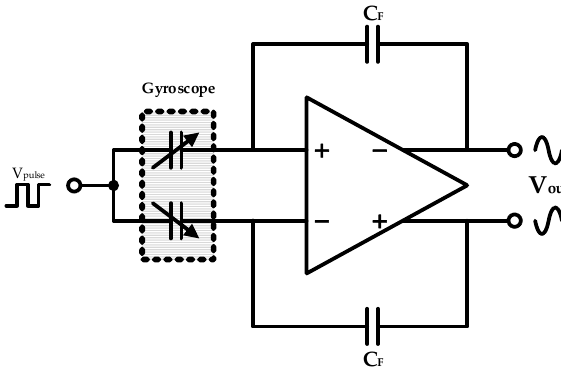
Figure 5. C / V conversion stage in gyroscope interface Figure 5. C/V conversion stage in gyroscope interface ASICs. Figure 5. C/V conversion stage in gyroscope interface ASICs.